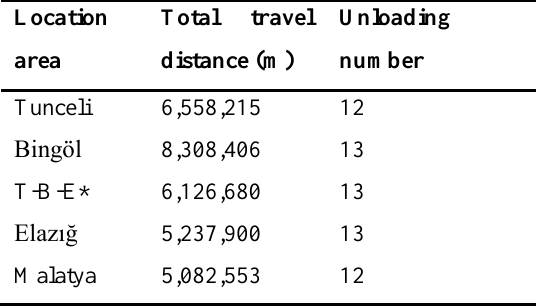
Table 2. Total travel distance and truck unloading